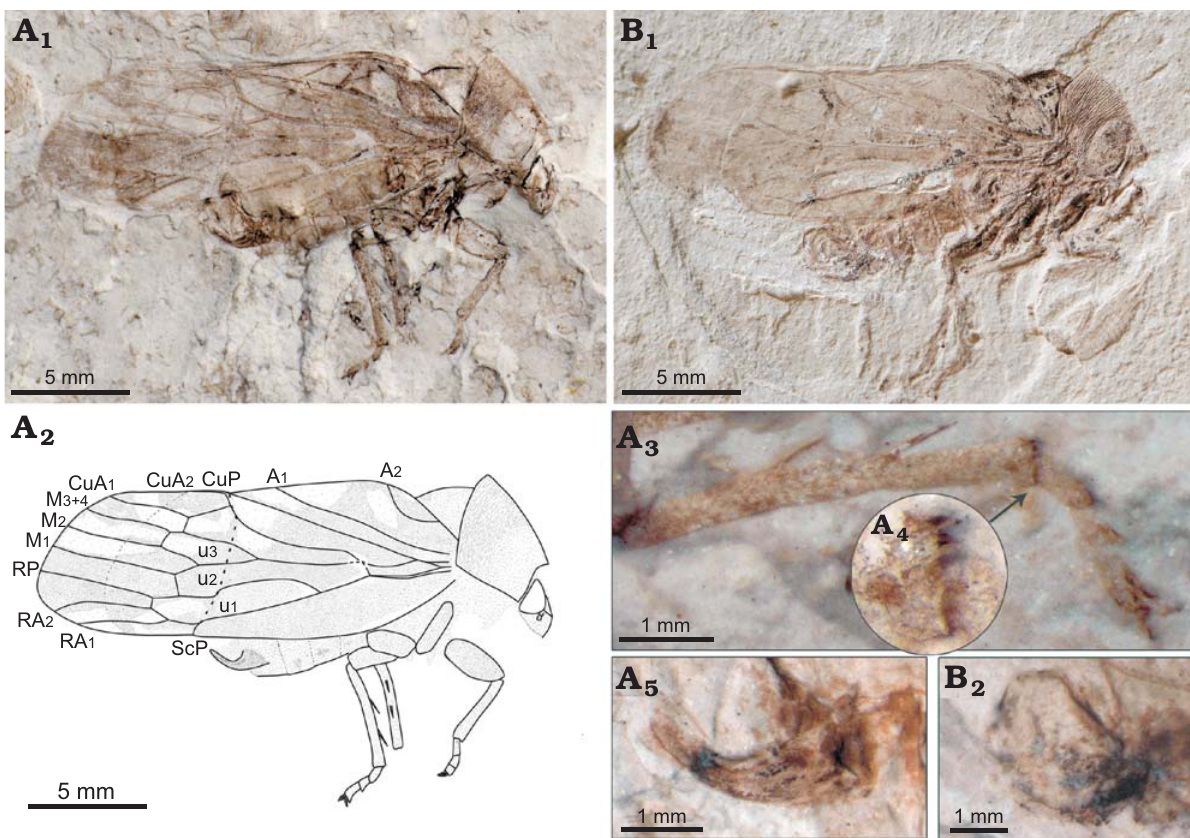
Fig. 2. Hairy cicada Sanmai kongi sp. nov. from the upper Middle–lower Upper Jurassic Daohugou beds. A . Holotype STMN48-1800a. Photograph under alcohol (A 1 ), explanatory drawing (A 2 ). Hind leg (A 3 ). Enlargement of apical teeth set of hind tibia (A 4 ). Photomicrograph of ovipositor (A 5 ). B . Paratype STMN48-1801. Photograph (B 1 ), photomicrograph of male genitalia (B 2 ). Abbreviations: A, anal vein; CuA, anterior branch of the cubitus vein; CuP, posterior branch of the cubitus vein; M, media vein; RA, anterior branch of the radial vein; RP, posterior branch of the radial vein; ScP, posterior branch of the subcosta vein; u, ulnar